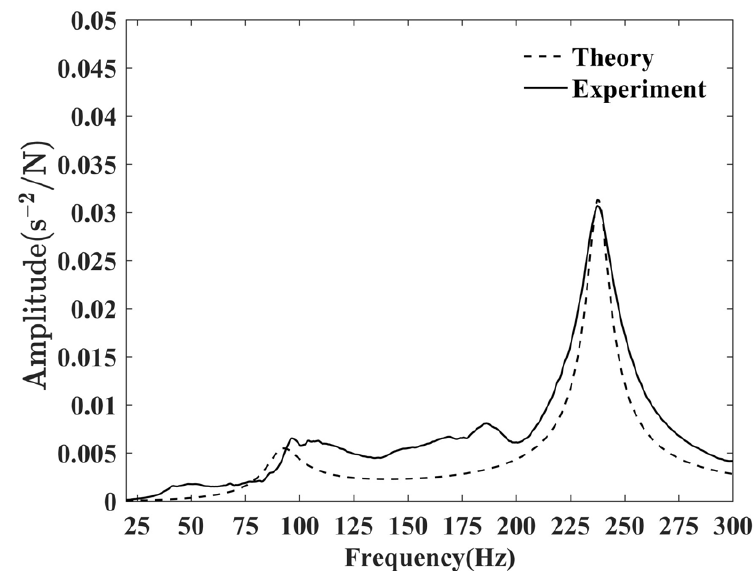
Figure 9. Comparison of the theoretical and experimental